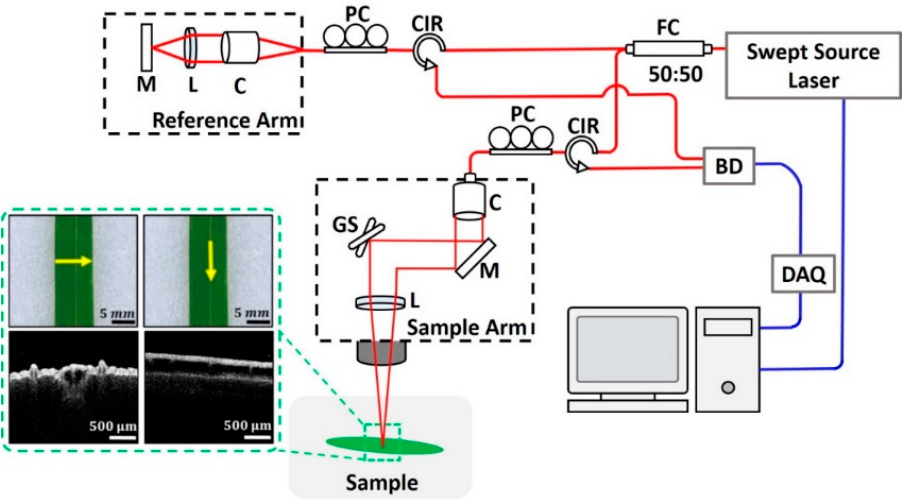
Figure 2. The schematic of the swept source optical coherence tomography (SS-OCT) optical screening system. Note the use of the following acronyms in the figure: BD: balanced detector, C: collimator,